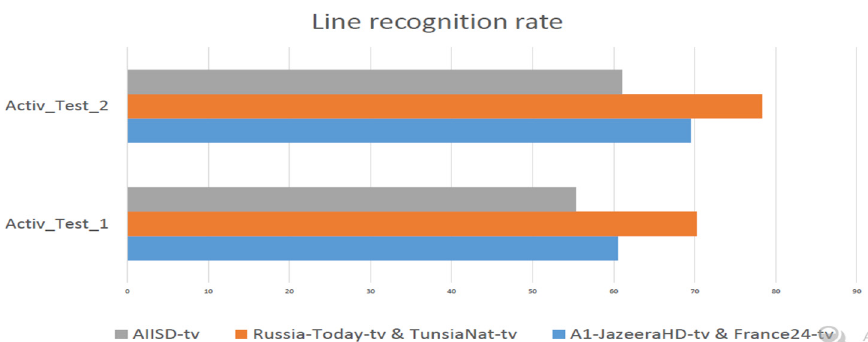
Figure 18. Comparison of proposed architecture with different architectures on line recognition rate (Activ dataset).